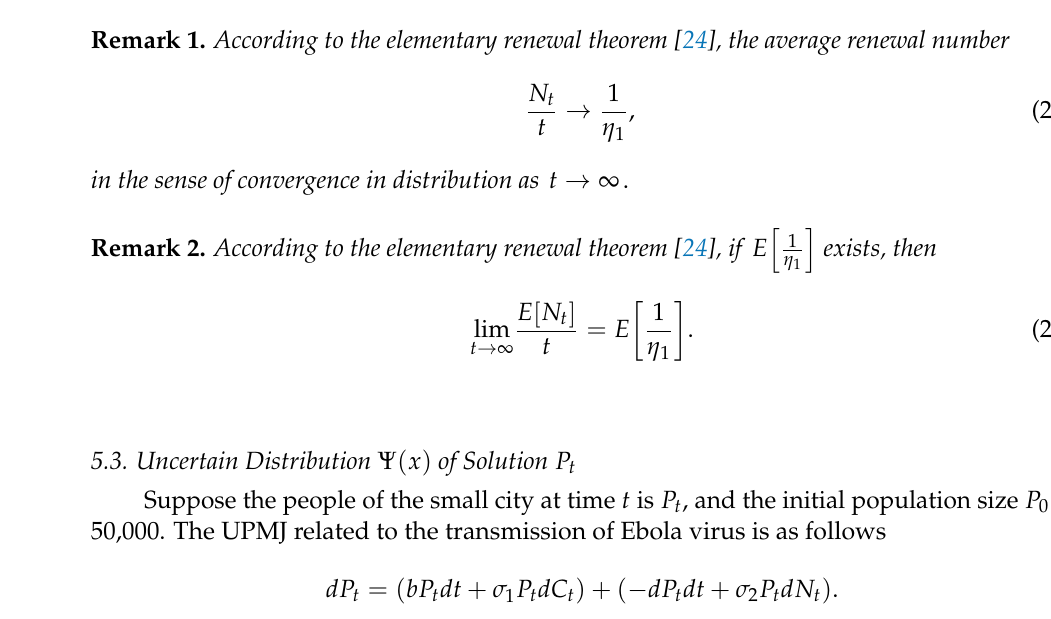
z ϒ of URP t ( z ) of URP N t t